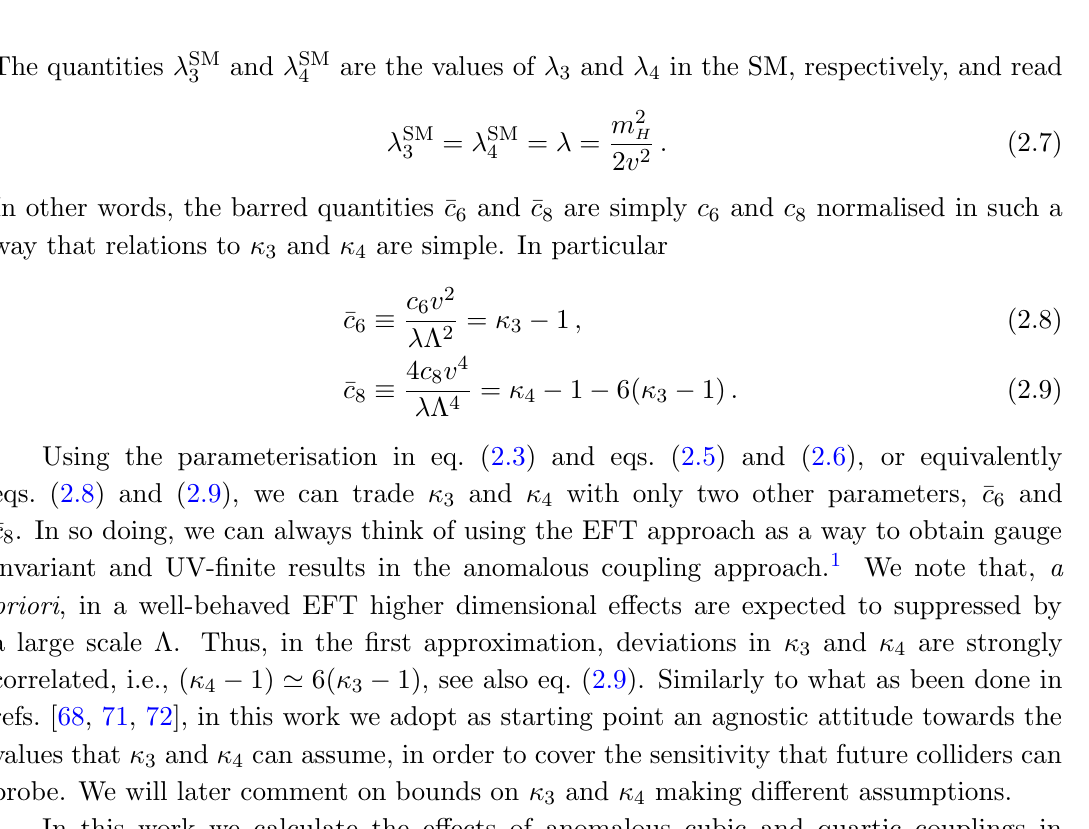
Figure 1 . Double Higgs production at LO in SM. The triangle diagram is sensitive to the cubic